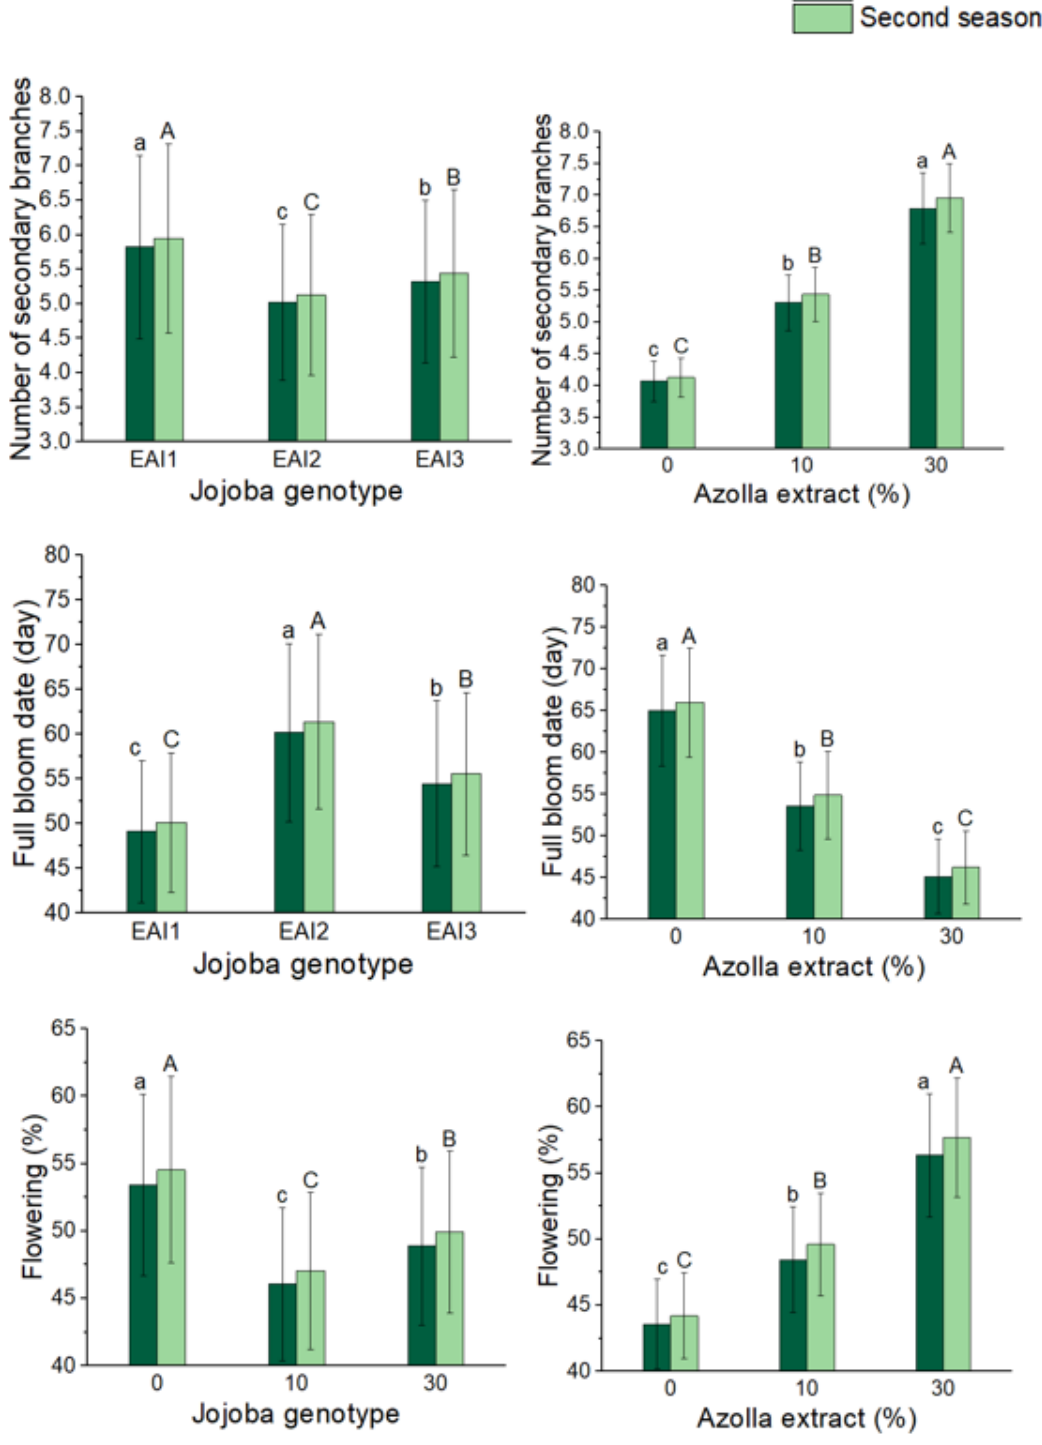
Figure 2. In both seasons, the mean values of the number of secondary branches, full bloom date (day), and flowering percentage (%) of jojoba shrubs were modified by plant genotypes and foliar application of Azolla filiculoides Lam. plant extract respectively. The data are expressed as a mean value ± SE. At the 0.05 level, bars with identical letters are not significant.